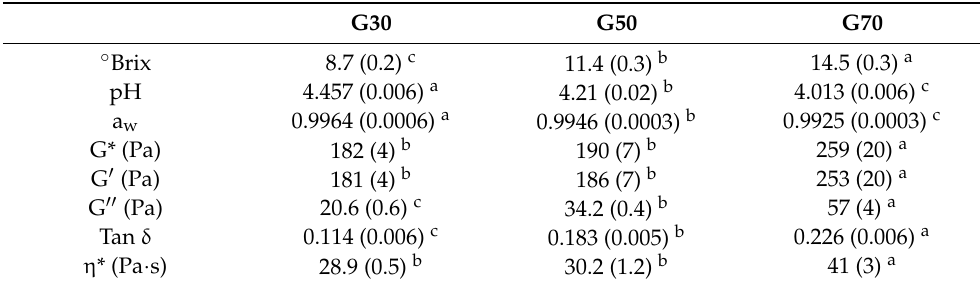
Table 1. Mean values (and standard deviations) of ◦ Brix, pH, a w , and rheological parameters (G*, complex modulus; G (cid:48) , storage modulus; G (cid:48)(cid:48) , loss modulus; Tan δ , loss tangent; and η *, apparent viscosity) of apricot gels before 3D printing.